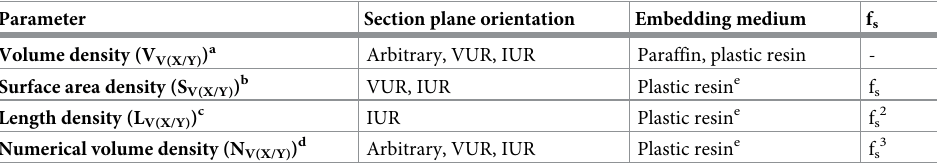
Table 1. Adequate sample section plane orientation, embedding medium and tissue shrinkage correction factor (f s ) for different quantitative morphological